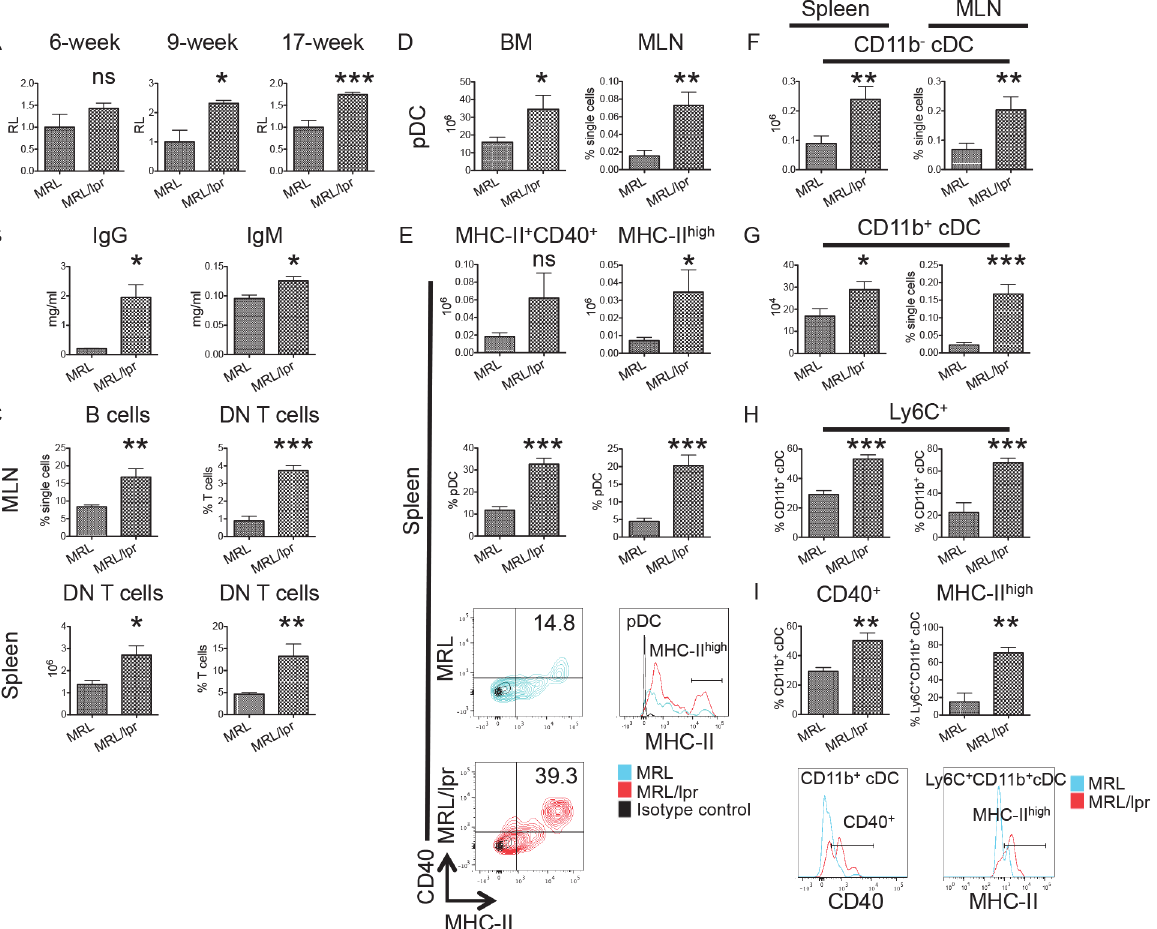
Fig 1. Immunogenic environment in 6-week-old MRL/lpr mice. (A) Anti-dsDNA IgG in the plasma of 6-week-, 9-week- and 17-week-old MRL and MRL/lpr mice as detected by ELISA. Data shown as relative levels (RL) were normalized to the average absorbance value of MRL mice at the same age, which was defined as 1. (B) Total IgG and IgM concentrations in the plasma of 6-week-old mice as detected by ELISA. (C-I) The percentages and absolute numbers of T, B, and dendritic cells in the spleen, mesenteric lymph node (MLN), and bone marrow (BM) of 6-week-old mice as determined by flow cytometry. (C, upper plots) The percentages of B cells (CD19 + ) and CD4 - CD8 - T cells (DN T cells, pre-gated on CD3 + ) in the MLN. (C, lower plots) The absolute cell numbers and percentages of DN T cells in the spleen. (D) pDCs (defined as CD11c + CD11b - B220 + Siglec-H + ) in the BM and MLN. (E) The absolute numbers and percentages of activated pDCs (MHC-II + CD40 + or MHC-II high pDCs) in the spleen. Representative flow cytometry plots of MRL and MRL/lpr are shown. (F and G) The absolute cell numbers and percentages of CD11b - cDCs (CD11c + CD11b - B220 - Siglec-H - MHC-II + ) and CD11b + cDCs (CD11c + CD11b + B220 - MHC-II + ) in the spleen and MLN. (H) Percentages of Ly6C + cells in CD11b + cDCs in the spleen and MLN. (I) The percentage of CD40 + cells in CD11b + cDCs in the spleen and the percentage of MHC-II high cells in Ly6C + CD11b + cDCs in the MLN. Representative flow cytometry plots of MRL and MRL/lpr are shown. ns: not significant, * P < 0.05, ** P < 0.01, *** P < 0.001, student ’ s t -test. Data are shown as mean + standard error of the mean (SEM), n = 3 mice in each